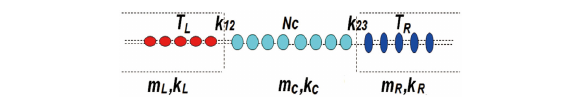
FIGURE 1 | Schematic of the one-dimensional atomic chain model, adapted with permission from the copyright holder (American Physical Society), Zhang et al.